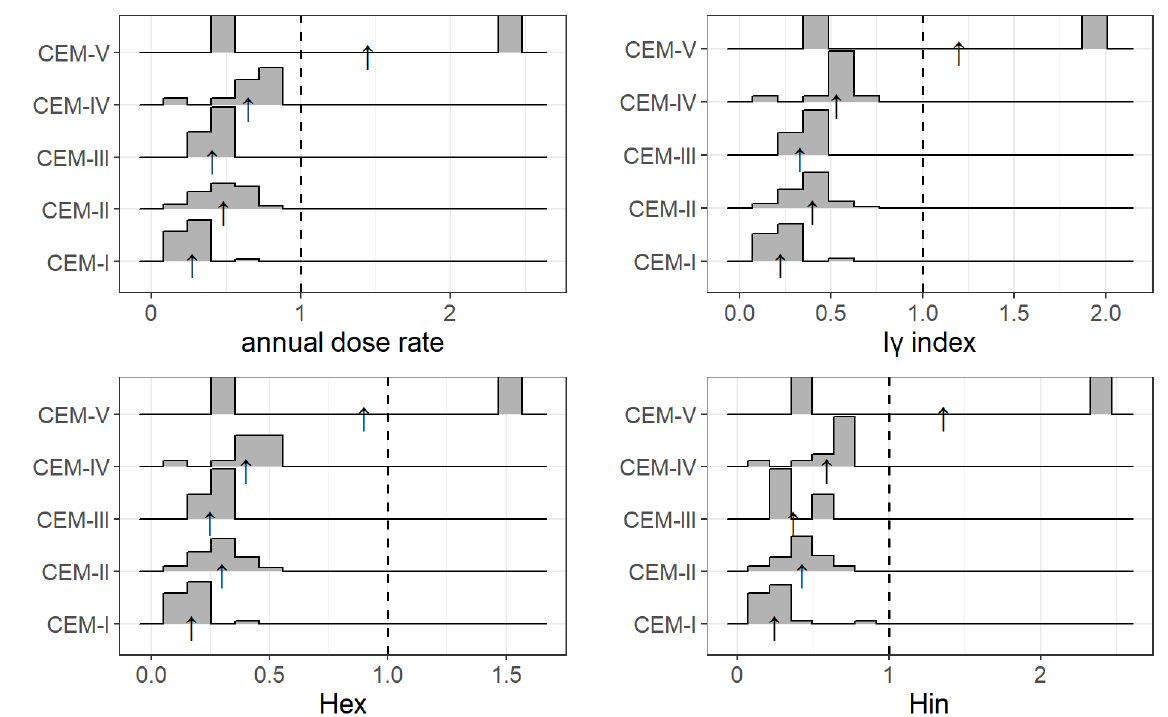
Figure 7. Histogram graphs for hazard indices E , H ex , H in , and I γ for five types of cements, based on such data from Table 4, for which the authors provided information on the type of cement. The arrows indicate the weighted averages within the groups.